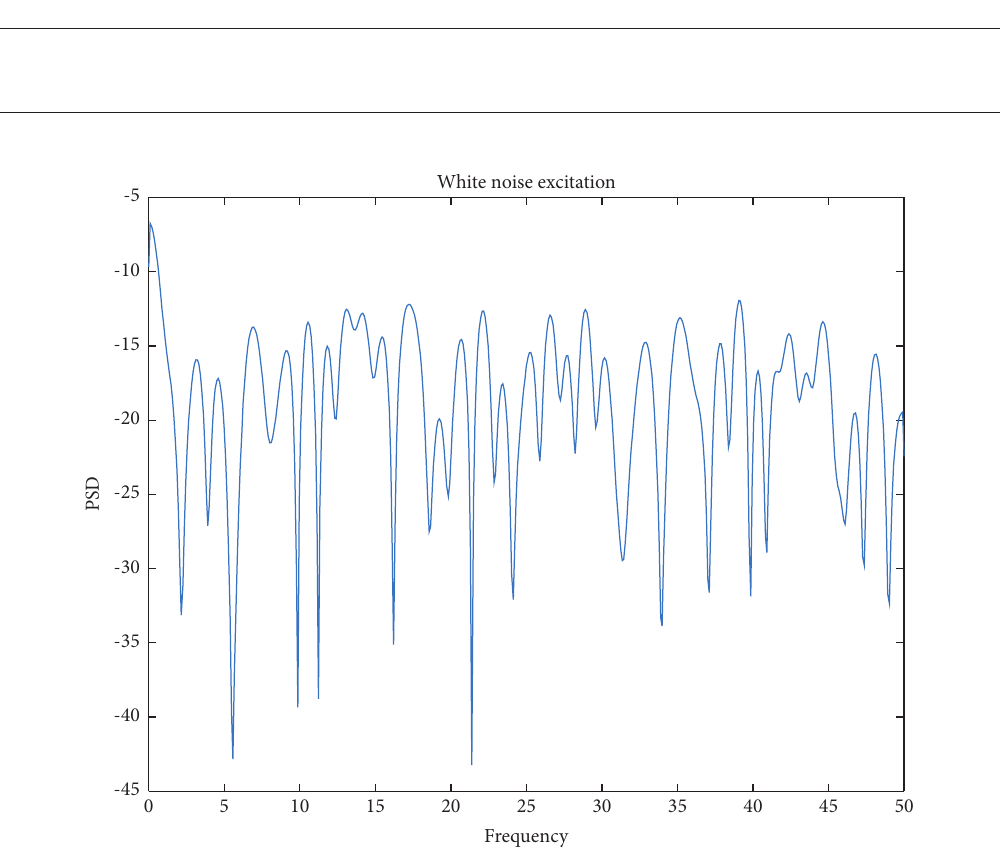
Figure 8: PSD information of the excitation